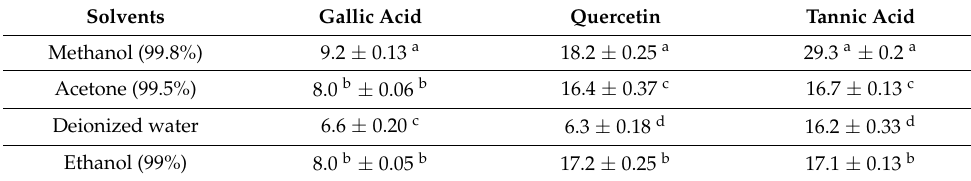
Table 3. Effect of different solvents on extraction of gallic, quercetin, and tannic acid from the leaf extract of J. procera ( µ g/g DW).